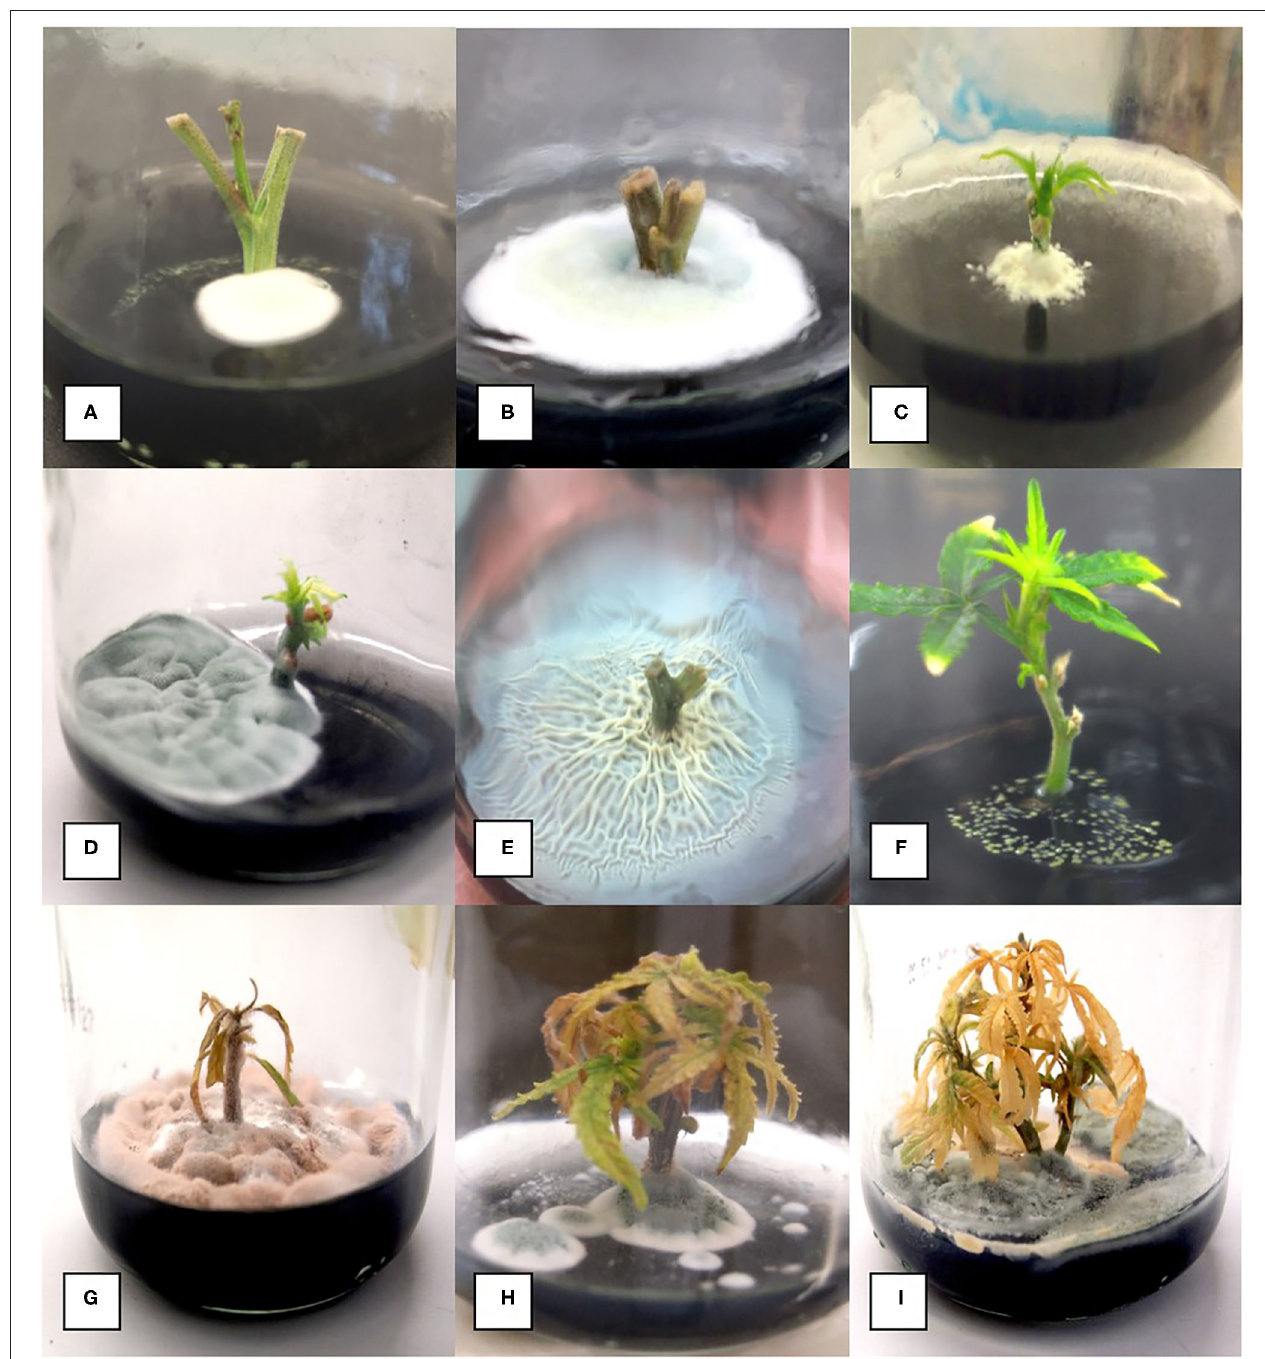
FIGURE 4 | Range of microbial contaminants emerging from surface-sterilized nodal stem explants at various times after placement on MM containing activated charcoal. (A) Early emergence of Penicillium species. (B) Large colony of Penicillium growing from a nodal explant. (C) Colony of Chaetomium emerging from a nodal explant. (D) Large colony of Penicillium growing out of a nodal stem explant. (E) Extensive Bacillus growth emerging from a nodal stem explant. (F) Growth of Pseudomonas from a stem explant. (G–I) Death of established shoots from nodal stem segments due to contamination by microbes appearing later during plantlet